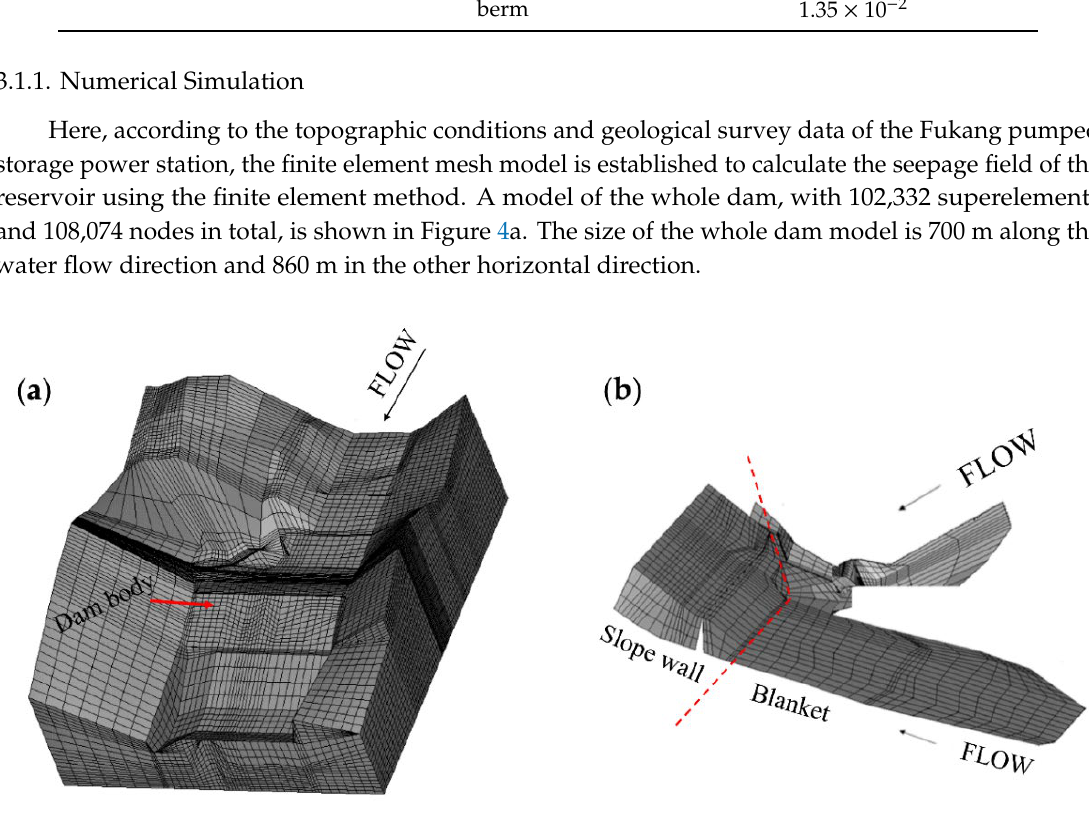
Figure 5. Potential distributions of the seepage field at a typical cross-section of the dam body: ( a ) in the designed flood level condition; ( b ) in the check flood level condition. 3.1.2. Proposed Calculation Method According to the engineering design information, the values of the variables needed for calculations are depicted in Figure 6. We conclude the following: 𝑡𝑡 = 1 mm, δ = 1 mm, γ = 16.29, 𝑚𝑚 1 = 0.82, 𝑚𝑚 2 = 0.52, 𝐿𝐿 0 = 142.54 m, 𝐵𝐵 𝑡𝑡 = 205.26 m 𝐻𝐻 1 = 𝑢𝑢𝑢𝑢𝑐𝑐𝑡𝑡𝑢𝑢𝑒𝑒𝑥𝑥𝑚𝑚 𝑤𝑤𝑥𝑥𝑡𝑡𝑒𝑒𝑢𝑢 𝑙𝑙𝑒𝑒𝑙𝑙𝑒𝑒𝑙𝑙 − 1795.8 m. By substituting the above values into Equation (15), the seepage flux of the Fukang slope-wall rock-fill dam can be calculated as shown in Table 2.